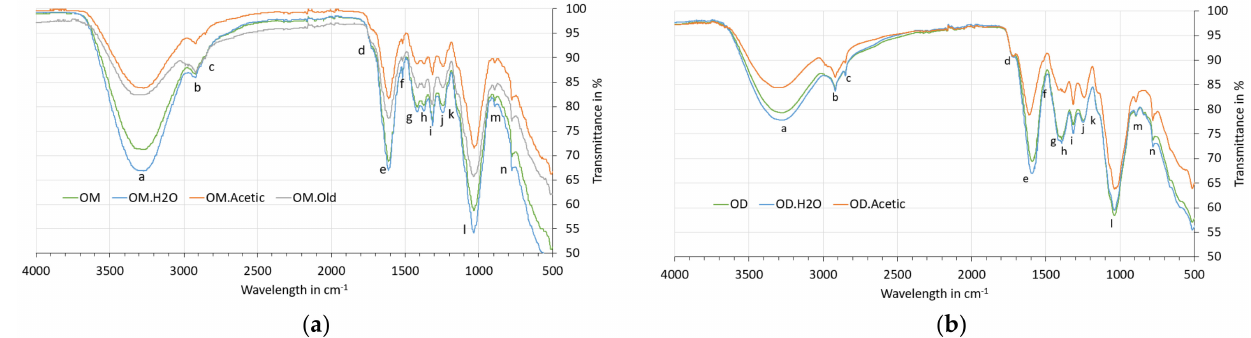
Figure 4. FTIR spectra for untreated and treated: ( a ) OM cladodes, ( b ) OD